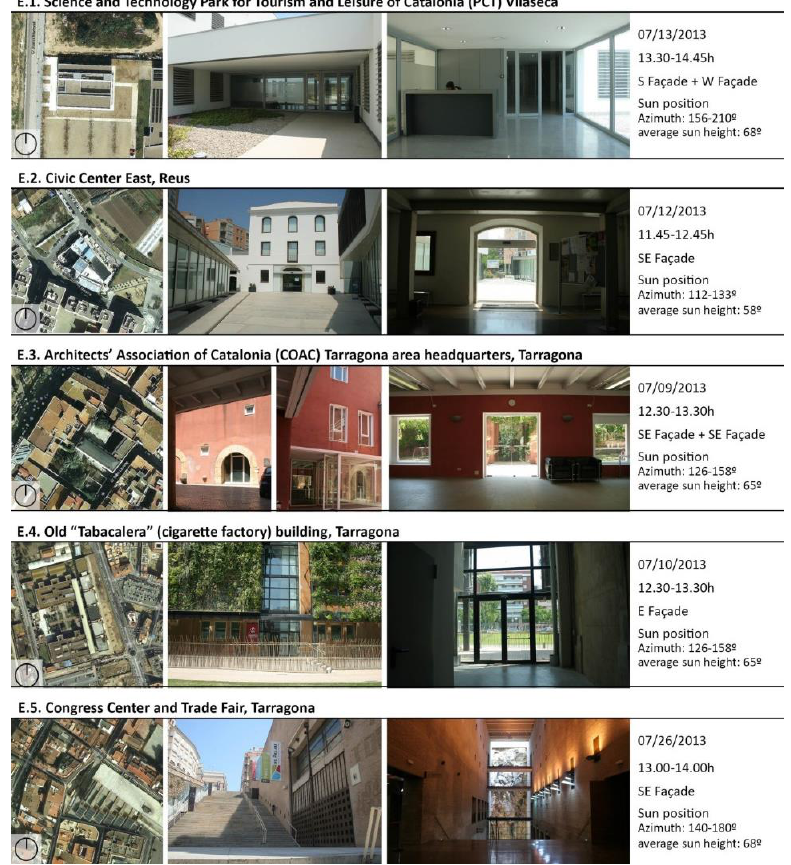
Figure 6. Record cards of case studies from E.1 to E.5.